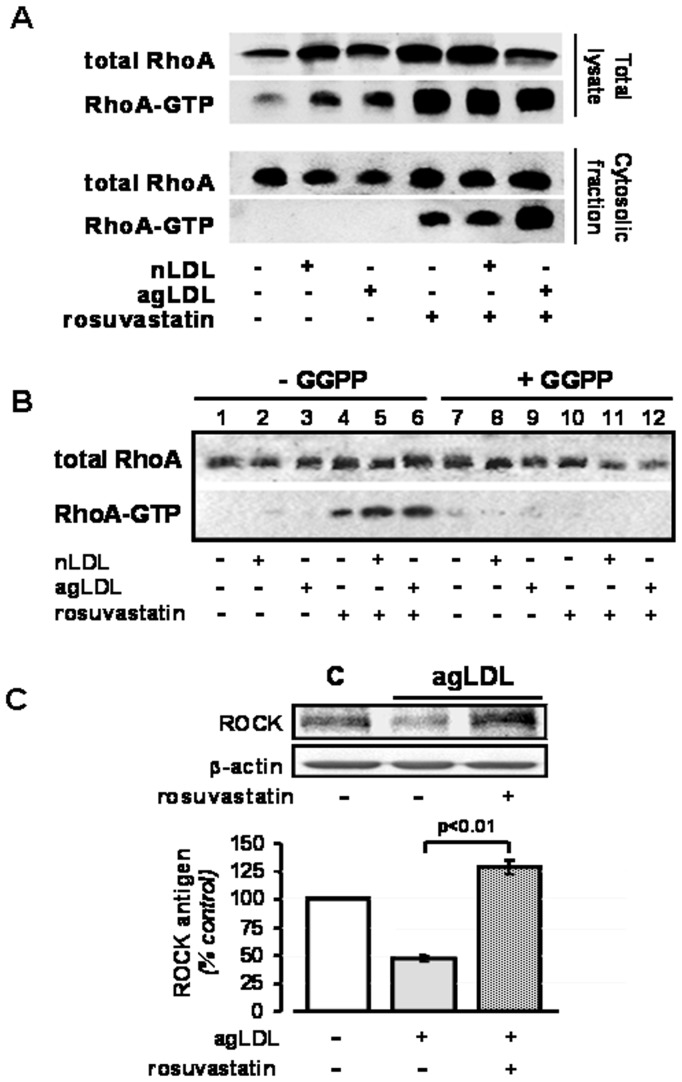
Increased levels of RhoA-GTP in cytosol of human VSMC exposed to agLDL in the presence of rosuvastatin.(A) Antigen (total RhoA) and active RhoA (RhoA-GTP) levels in total cell lysates and cytosol extracts of VSMC treated without/with rosuvastatin in absence/presence of nLDL and agLDL for 24 hours. Levels of active RhoA were determined by a pull down assay with GST-rothekin. Note the strong band for active RhoA in the cytosol of rosuvastatin treated cells. (B) Total and active RhoA levels in the cytosol fraction of VSMC treated without and with rosuvastatin +/−10 µM geranyl-geraniol pyrophosphate (GGPP), in the absence and presence of nLDL and agLDL for 24 hours. (C) Western blot analysis for ROCK antigen levels in cytosol extracts of cells exposed for 24 hours to agLDL in the absence and presence of rosuvastatin. C denotes the control non treated group.